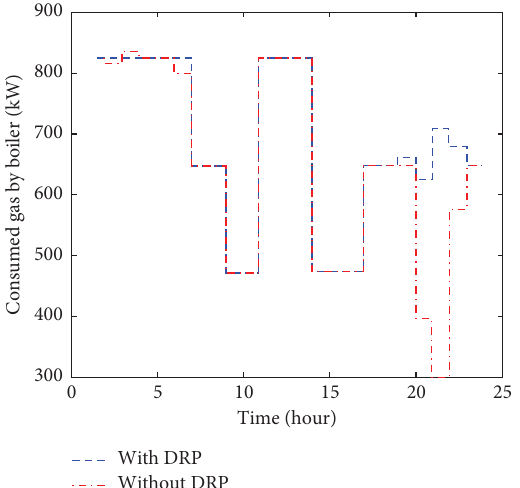
Figure 16: Te gas consumed by the boiler.